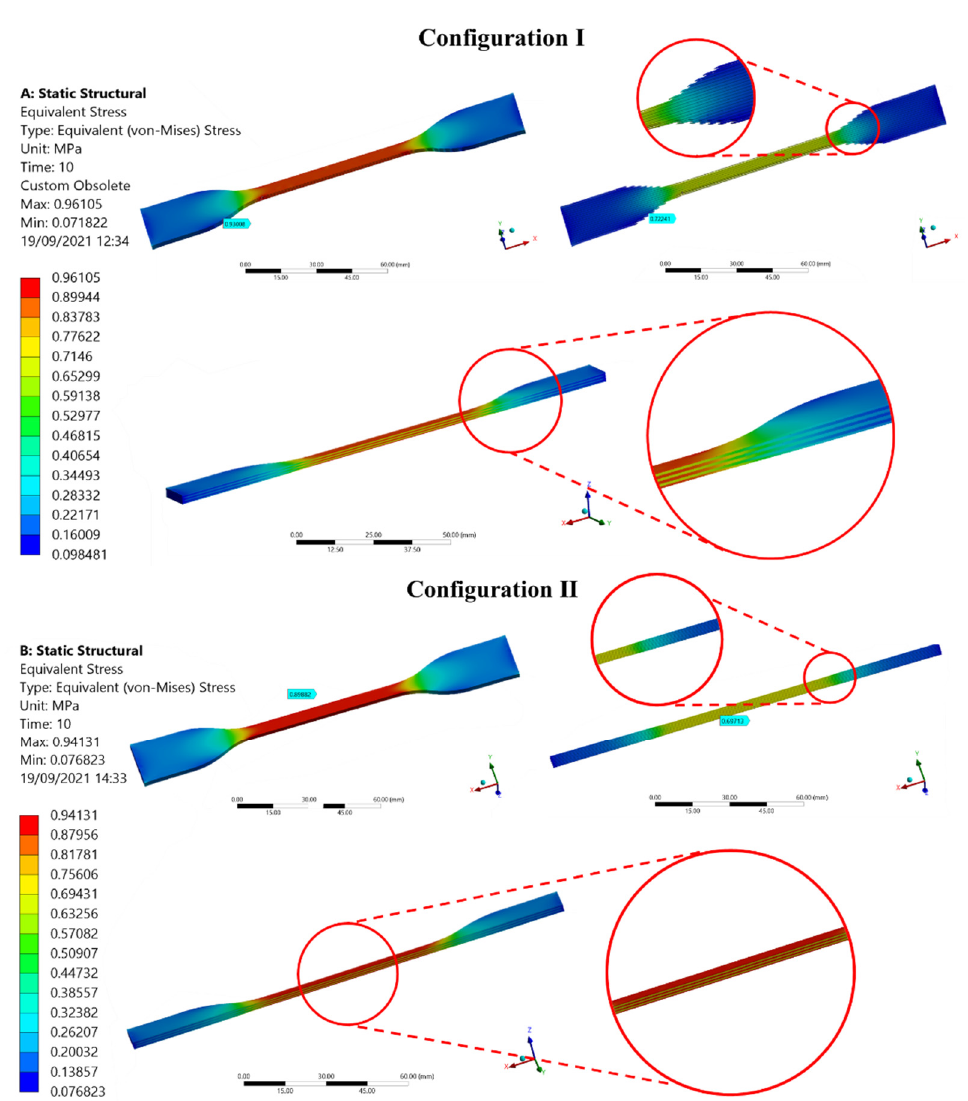
Figure 10. Ansys static structural environment. Results of Von Mises Stress distribution in configura- tions I and